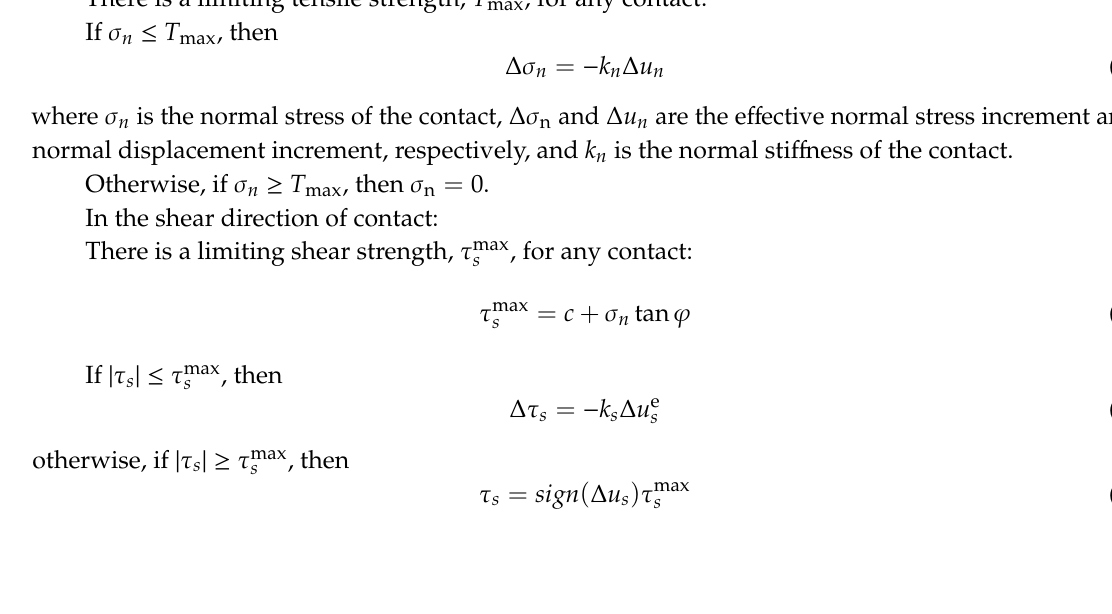
Figure 3. Photos of the “3.24” rock burst in the 5521 ‐ 20 working face: ( a ) Failure of hydraulic supports; and ( b ) Cracking of the bottom coal in headgate.